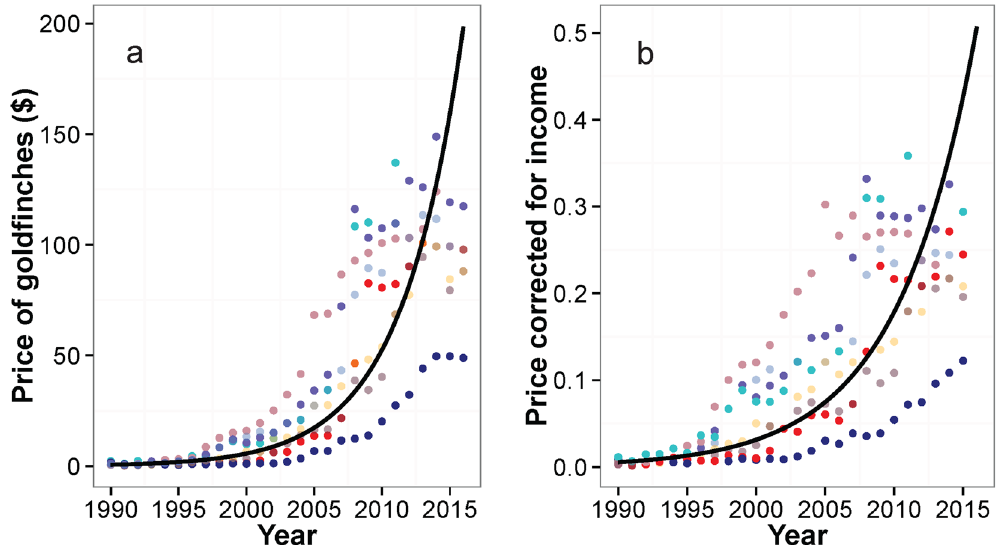
Figure 4. Temporal pattern of the price of the European goldfinch ( Carduelis carduelis ) in Algeria. ( a ) Price of adult male. ( b ) Price of adult male corrected for the monthly per capita income. The exponential curve in ( a ) and ( b ) represents the average across provinces. Prices were converted to US dollars ($). Colors refer to provinces; Pink: Algiers, Cyan: Annaba, Blue: Blida, Red: Guelma, Purple: Jijel, Grey: Oran, Yellow: Skikda, and Beige: Souk Ahras.